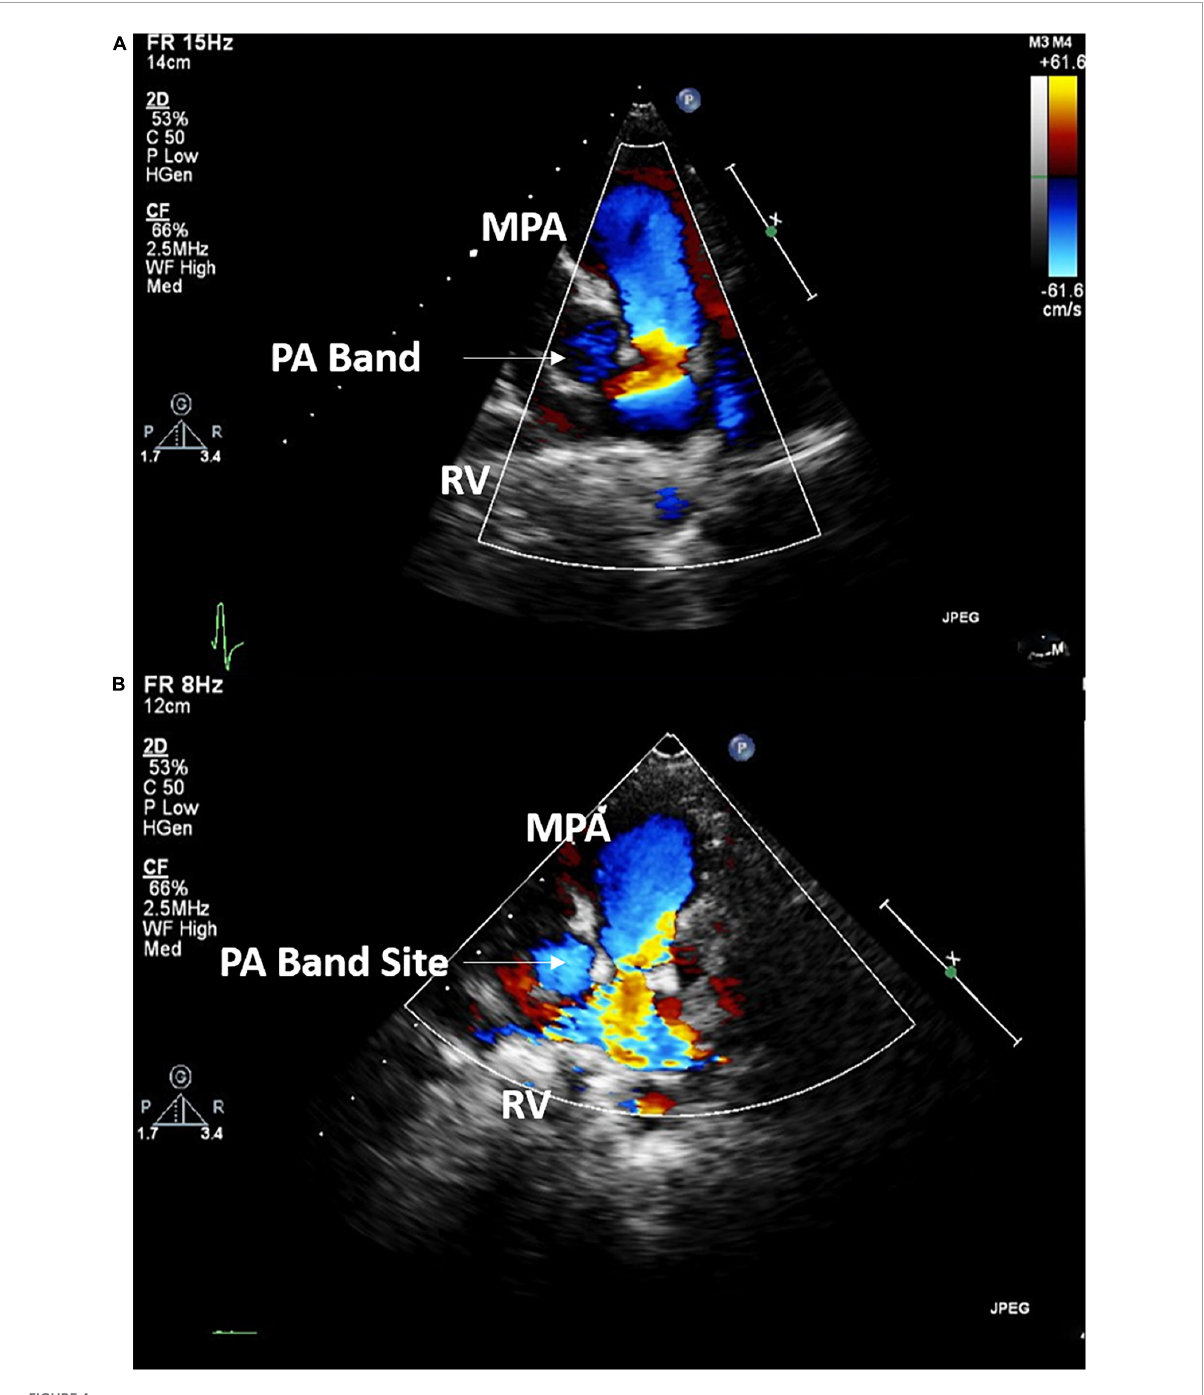
FIGURE4 Echocardiographic imaging of Case I before (A) the debanding procedure and at 3-year follow up following the catheter-based debanding (B) . RV, right ventricle; MPA, Main pulmonary artery; PA, Pulmonary artery.